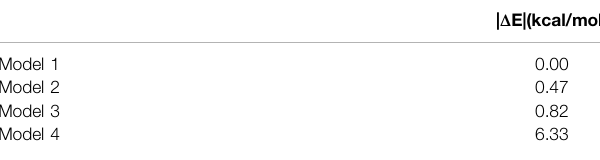
TABLE3| PBE/DGDZVPrelativeenergiescomputedforallinvestigated modelsin gas